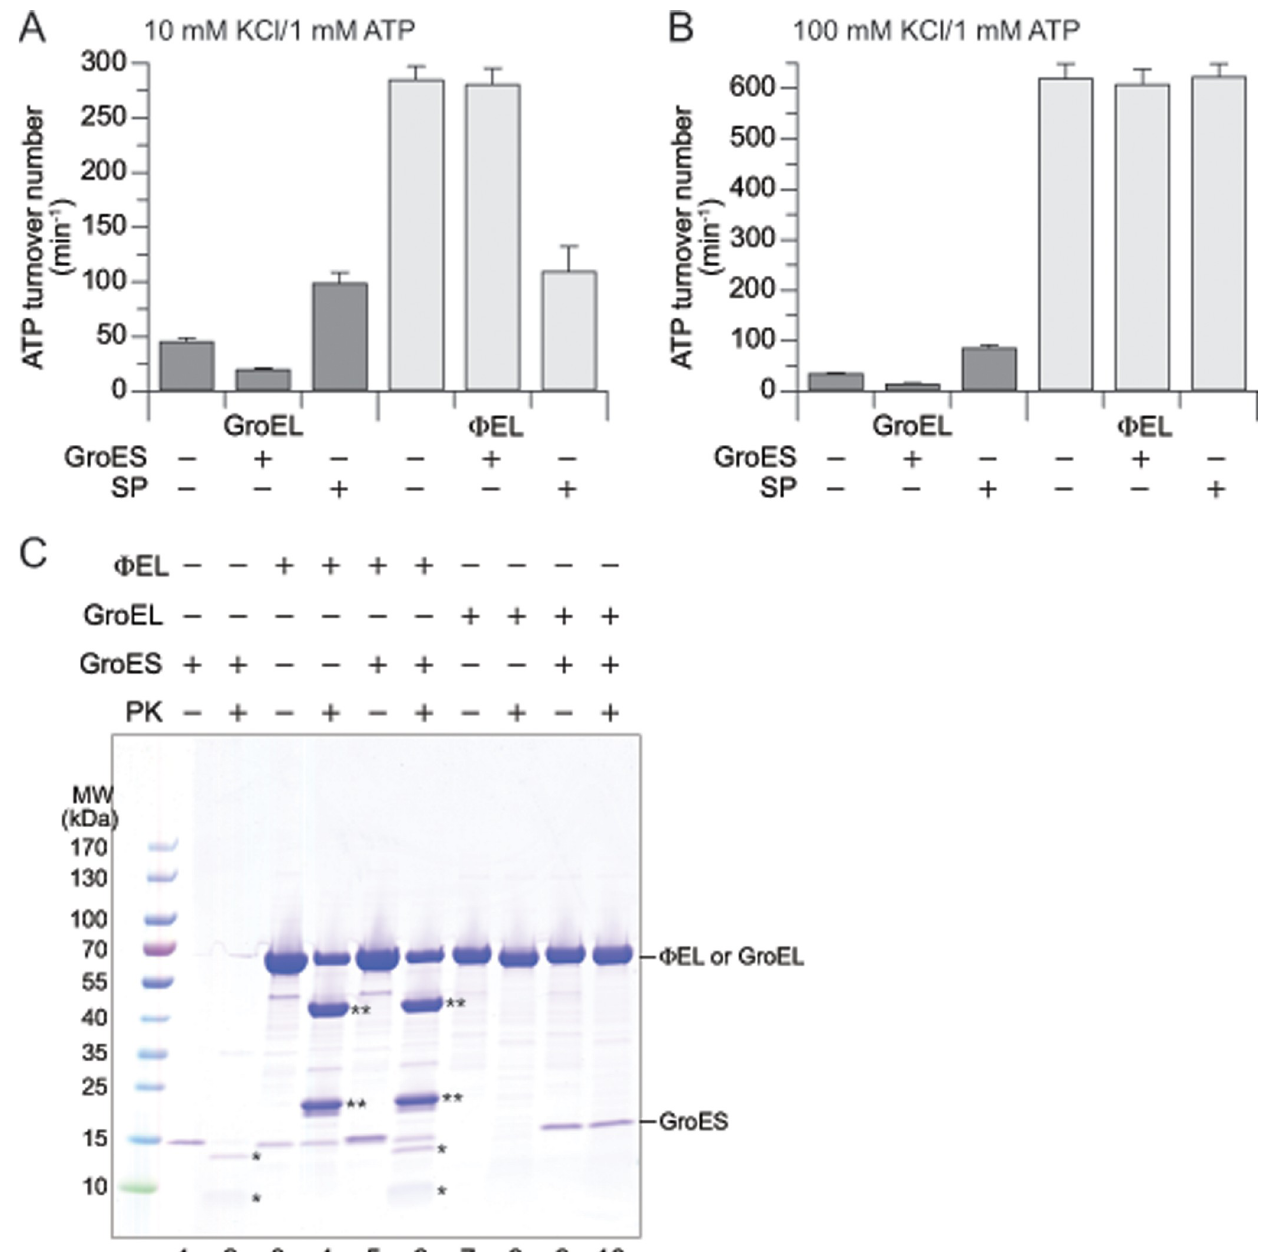
Fig 3. Effect of GroES on GroEL and ɸ EL. (A, B) ATPase activity of GroEL and ɸ EL in presence and absence of a two-fold excess of GroES or the model substrate DM-MBP. The buffer contained 10 mM (A) or 100 mM KCl (B) and the ATP concentration was 1 mM. The bar graph shows the averages from at least three experiments; error bars indicate standard deviations. (C) Proteinase K (PK) sensitivity of GroES alone, and of ɸ EL and GroEL in presence and absence of GroES. The experiment was performed in buffer 20 mM Tris-HCl pH 7.5, 100 mM KCl, 5 mM MgCl 2 and 0.2 mM ADP [42]. The concentrations of GroEL and ɸ EL were 1.5 μ M; GroES was at 1.0 μ M. After 3 min incubation with 0.2 g L -1 PK at 25˚C, the protease reaction was stopped by addition of phenylmethylsulfonyl fluoride (1 mM). The mixtures were analyzed by SDS-PAGE. � , proteolytic fragments of GroES; �� , proteolytic fragments of ɸ